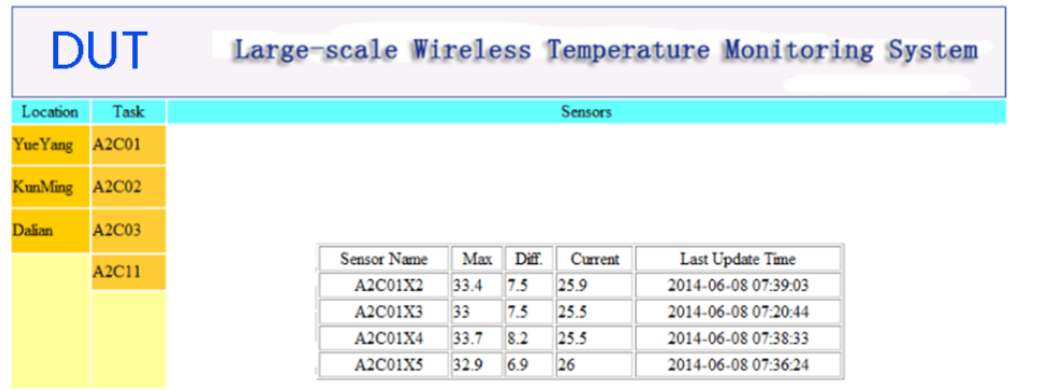
Figure 10. Remote access.